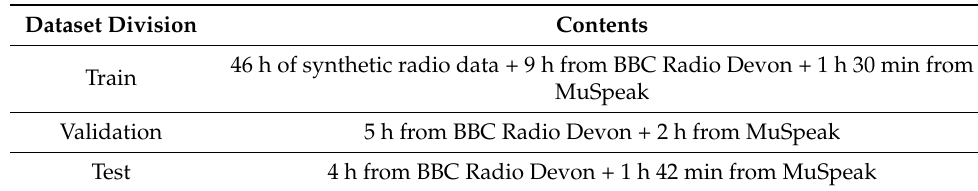
Table 4. Contents of train, validation, and test datasets for music-speech detection. Real-world radio data was collected from BBC Radio Devon and annotated by the authors. MuSpeak [38] already contains annotations for music and speech. 46 h of artificial radio-like examples were synthesised by the method presented in this study